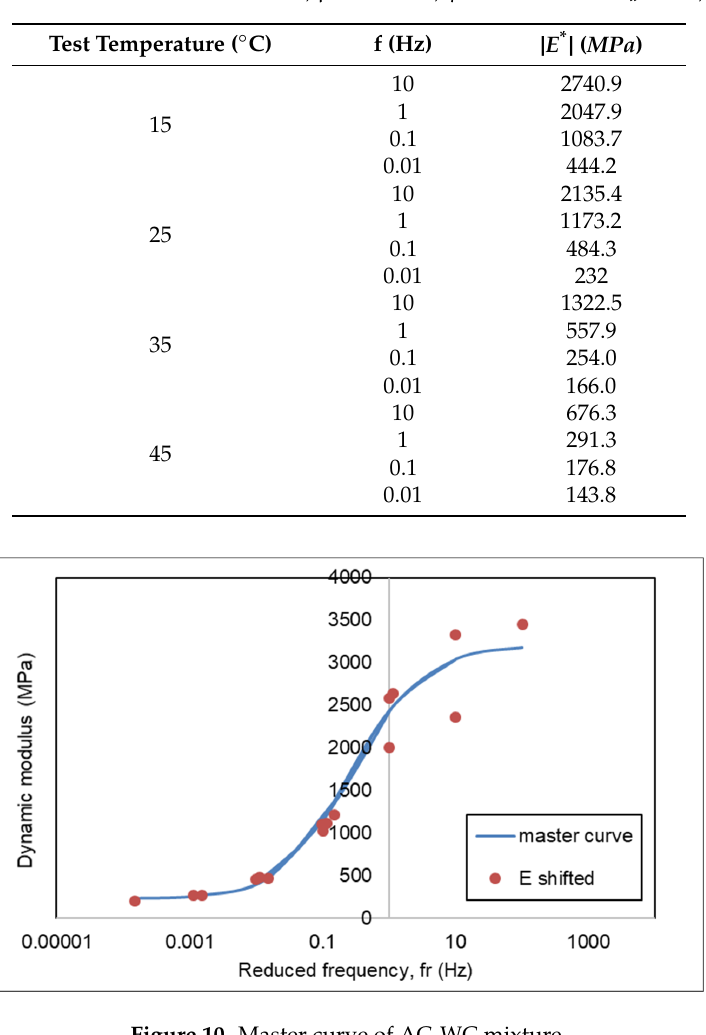
Table 8. Dynamic modulus of the HRS-WC asphalt mixture at a reference temperature of 25 ◦ C (with = 464,566.9 kPa and constants: δ = 5.11, β = − 0.7839, γ = − 1.143 and ∆ E | E ∗ | max